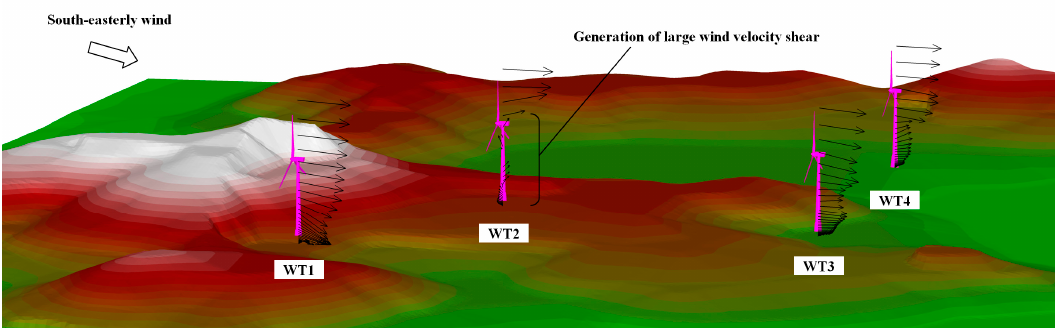
Figure 12. Wind velocity vectors at the wind turbine locations. Instantaneous field from the time indicated by “B” in Figure 10.